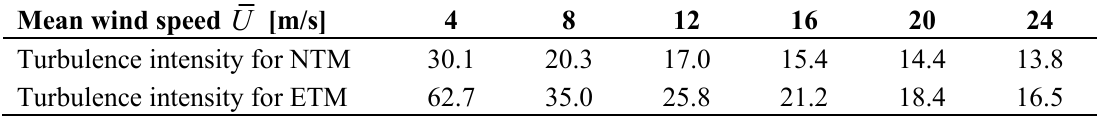
Table 3. Longitudinal turbulence intensity for all simulation